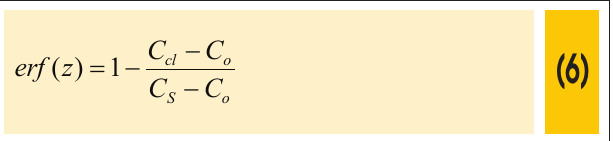
Figure 8 – Steady-state and nonsteady-state diffusion coefficients of chloride ions as a function of red mud content in concretes cured for 28 days, estimated from migration tests